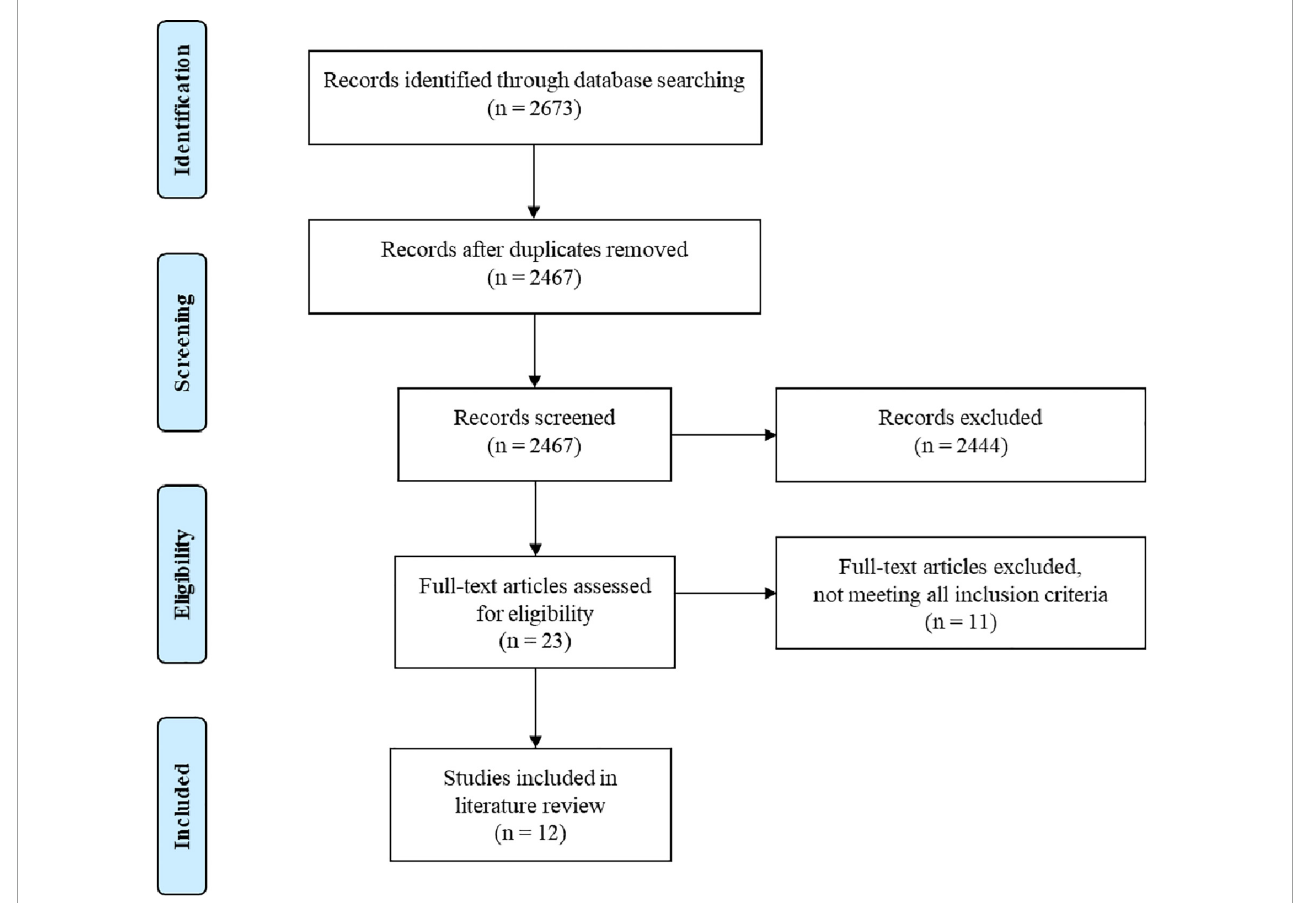
FIGURE1 An overview of the study selection